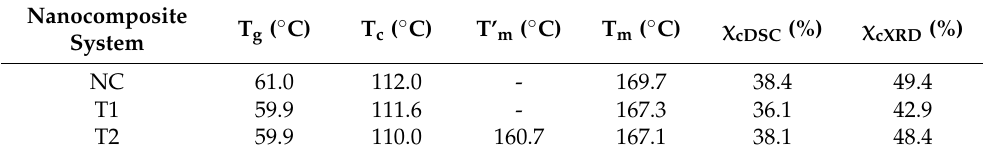
Table 3. DSC and crystallinity percentage of compatibilized conductive nanocomposite